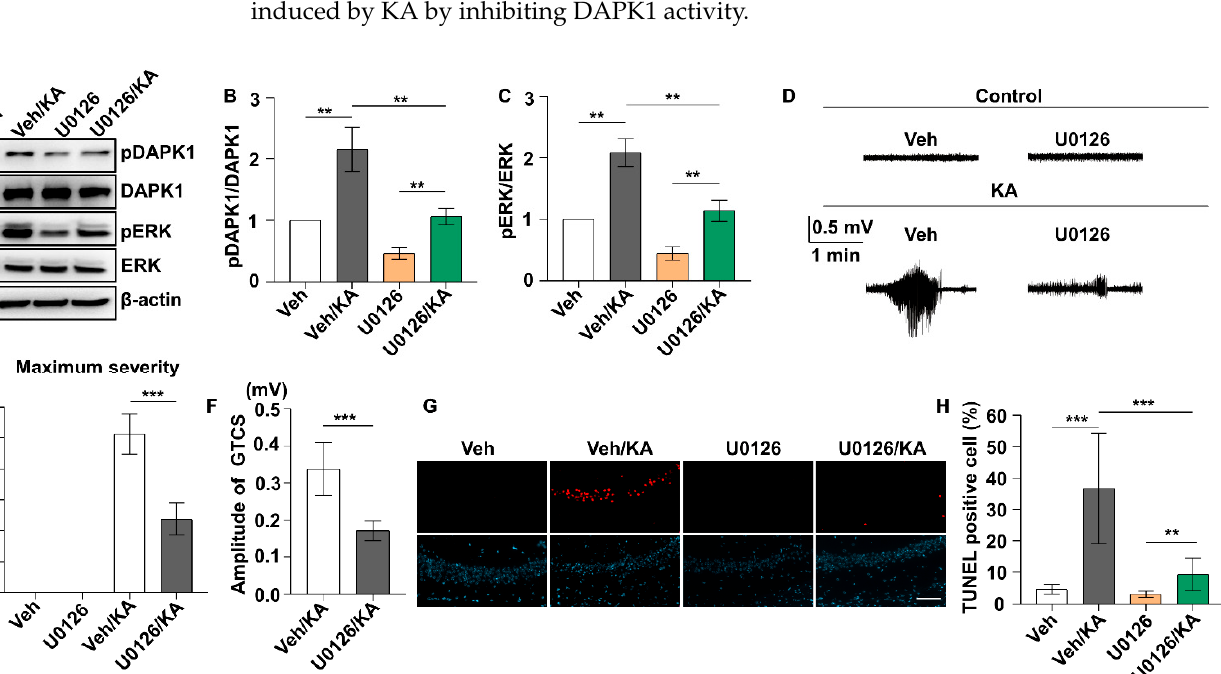
treated groups 72 h after KA treatment. ( H ) Statistical analysis of the TUNEL assay results (** p < 0.01, values were combined and are expressed as the mean ± SD. Experiments were performed in triplicate with at least three mice per group per